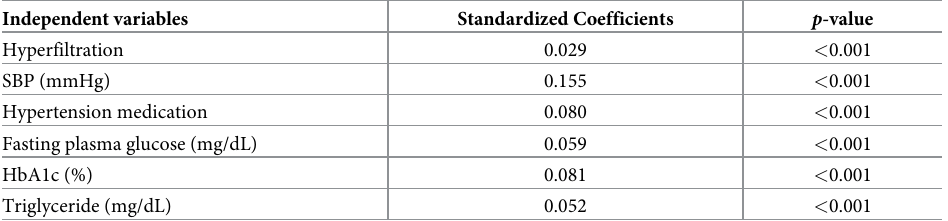
Table 3. Results of clinical and metabolic parameters � adjusted multiple logistic regression analysis with urine albumin creatinine ratio as the dependent